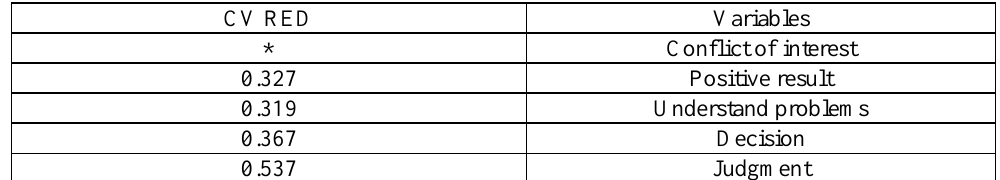
Table 7. CV RED index